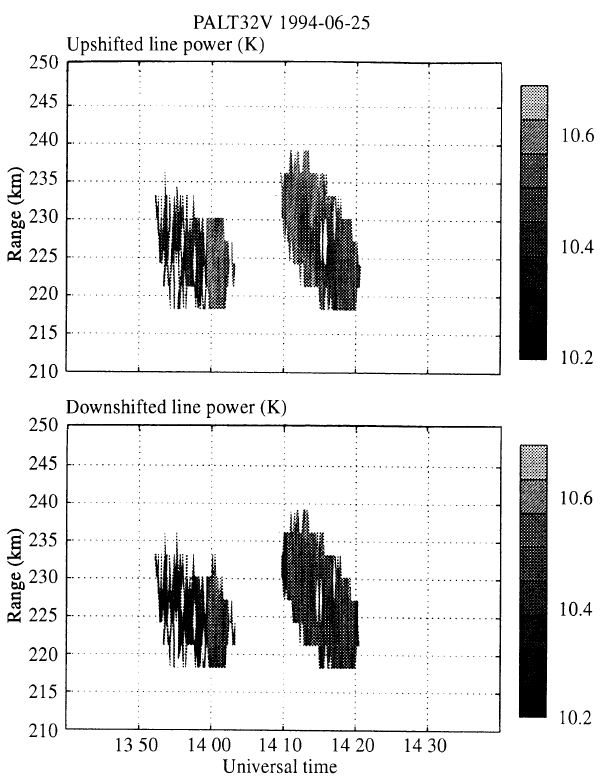
Fig. 8. The fitted upshifted and downshifted line power displayed as a function of range and time for the Gaussian model